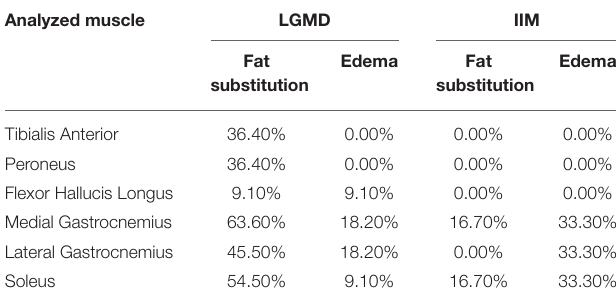
TABLE 2 | The percentage of people with high-grade fat substitution and edema of the calf muscles among patients with limb-girdle muscular dystrophy and idiopathic inflammatory